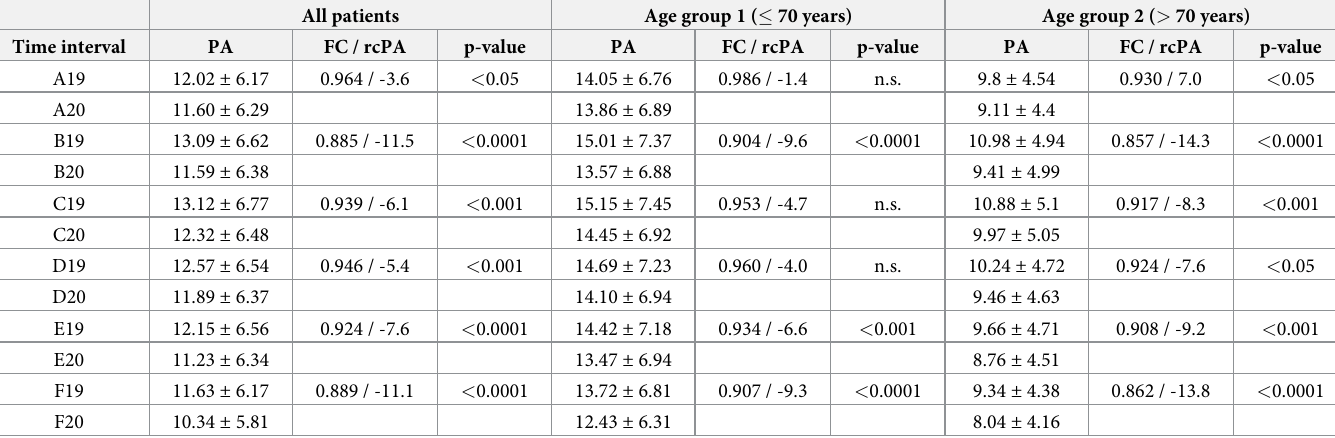
P-values refer to differences of mean physical activity (PA) of corresponding time intervals (A-F) in 2019 and 2020. Fold changes (FC) i.e., relative changes of physical activity (rcPA) for each pair of corresponding time intervals are